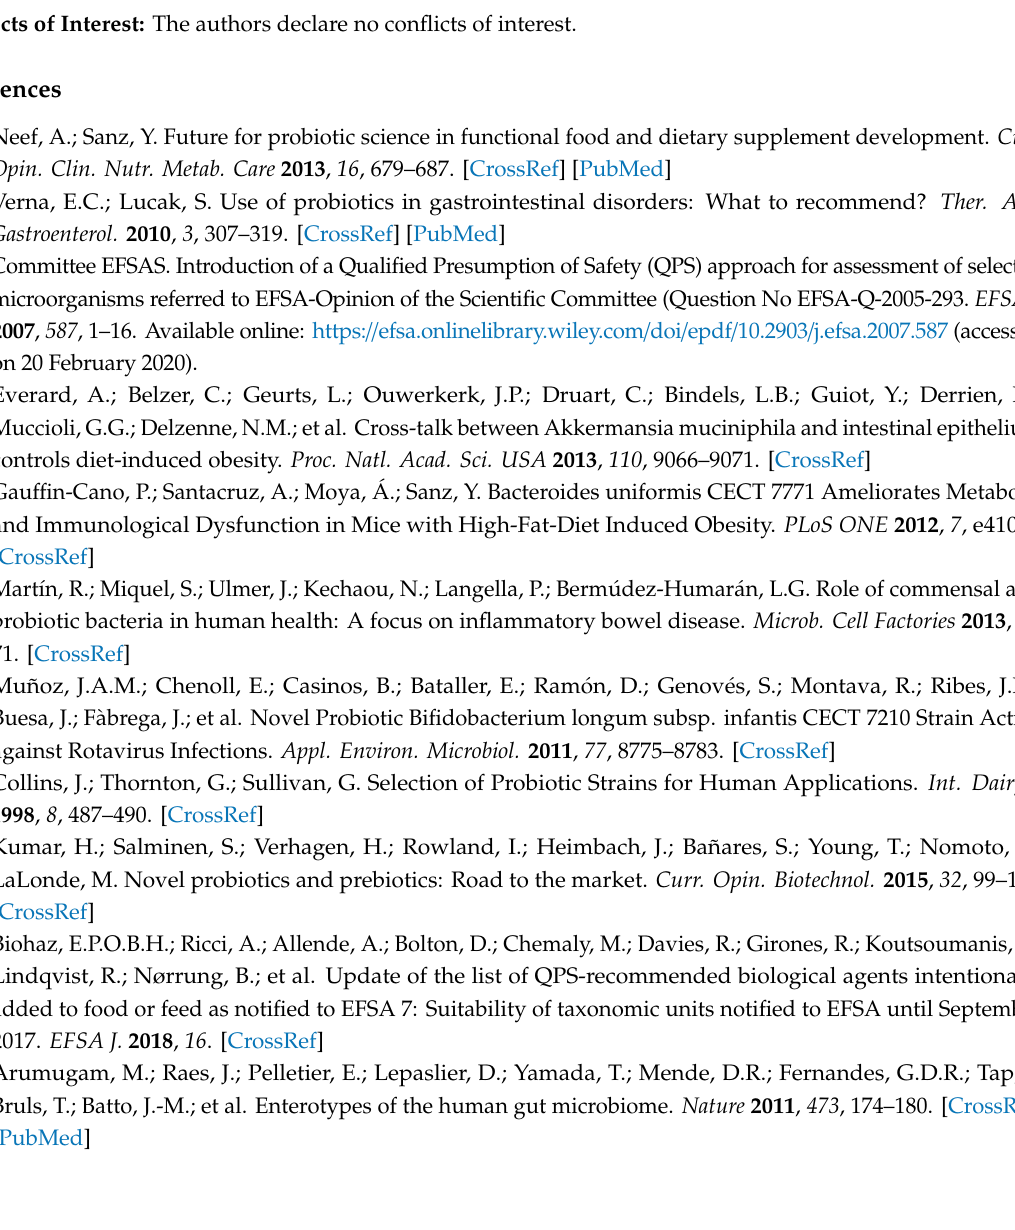
Figure S1: Body weight gain, food intake, and liver tissue weight variation during the safety assessment, Figure S2: Body weight gain and food intake during the safety assessment in male and female rats, Figure S3: Liver weight at the end of the study in male and female rats, Figure S4: ALP activity and creatinine and urea concentrations in serum of the experimental groups, Figure S5: ALP activity, creatinine, and urea concentrations in the serum of male and female rats, Figure S6: IL-10 and IFN- γ concentrations in serum and jejunum samples from females, Figure S7: IL-10 and IFN- γ concentrations in serum and jejunum samples from males, Figure S8: IL-10 / IFN- γ ratios in serum and jejunum samples for males and females, Figure S9: Distance-based redundancy analysis (dbRDA), Table S1: Lieberkhün crypts’ depth ( µ m) and the number of Goblet cells per crypt in all animals (50 animals, n = 10 per group) and in males and females (25 animals, n = 5 per group), at the end of the safety assessment of B. uniformis CECT